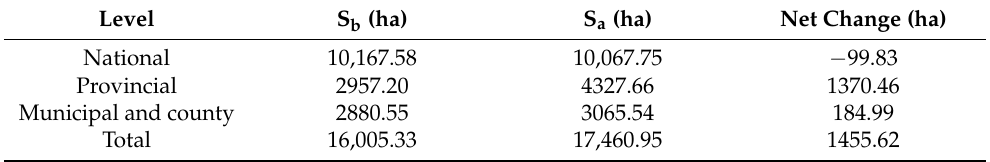
Table 6. Dynamic changes of mangrove area in the reserves of different levels before and after protection.